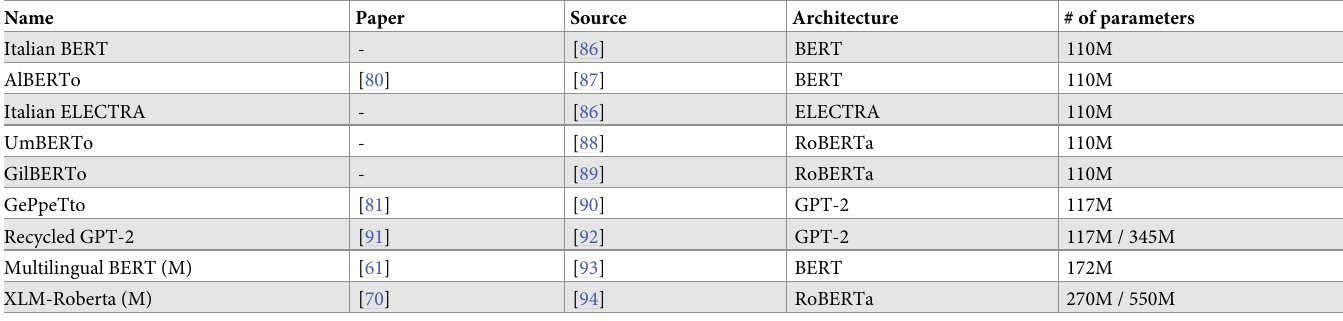
Table 2. Italian pre-trained transformer